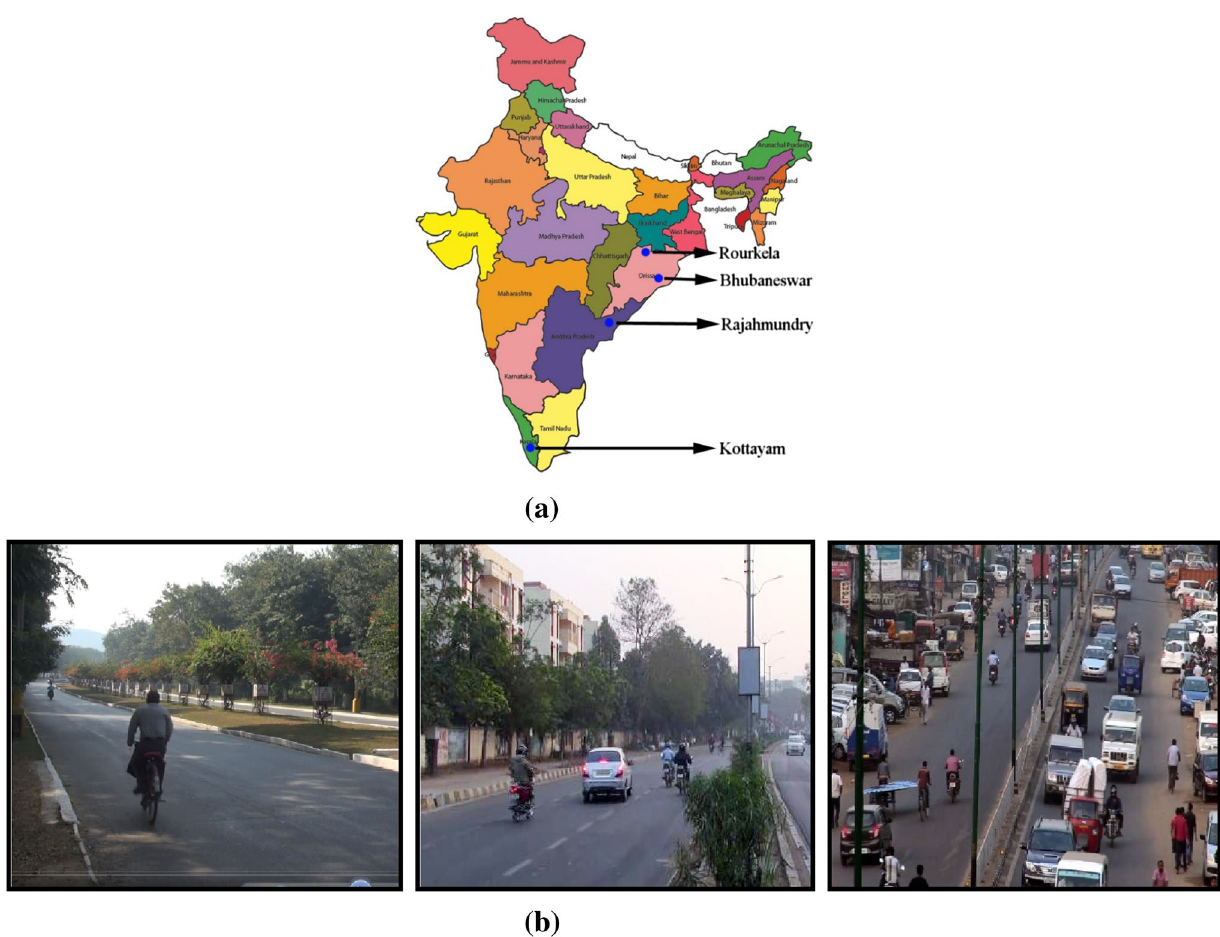
Fig. 1 Study locations and typical bicycle activities under differing conditions: a locations of studied cities in India; b schematic photographs of few bicycle facilities in the study